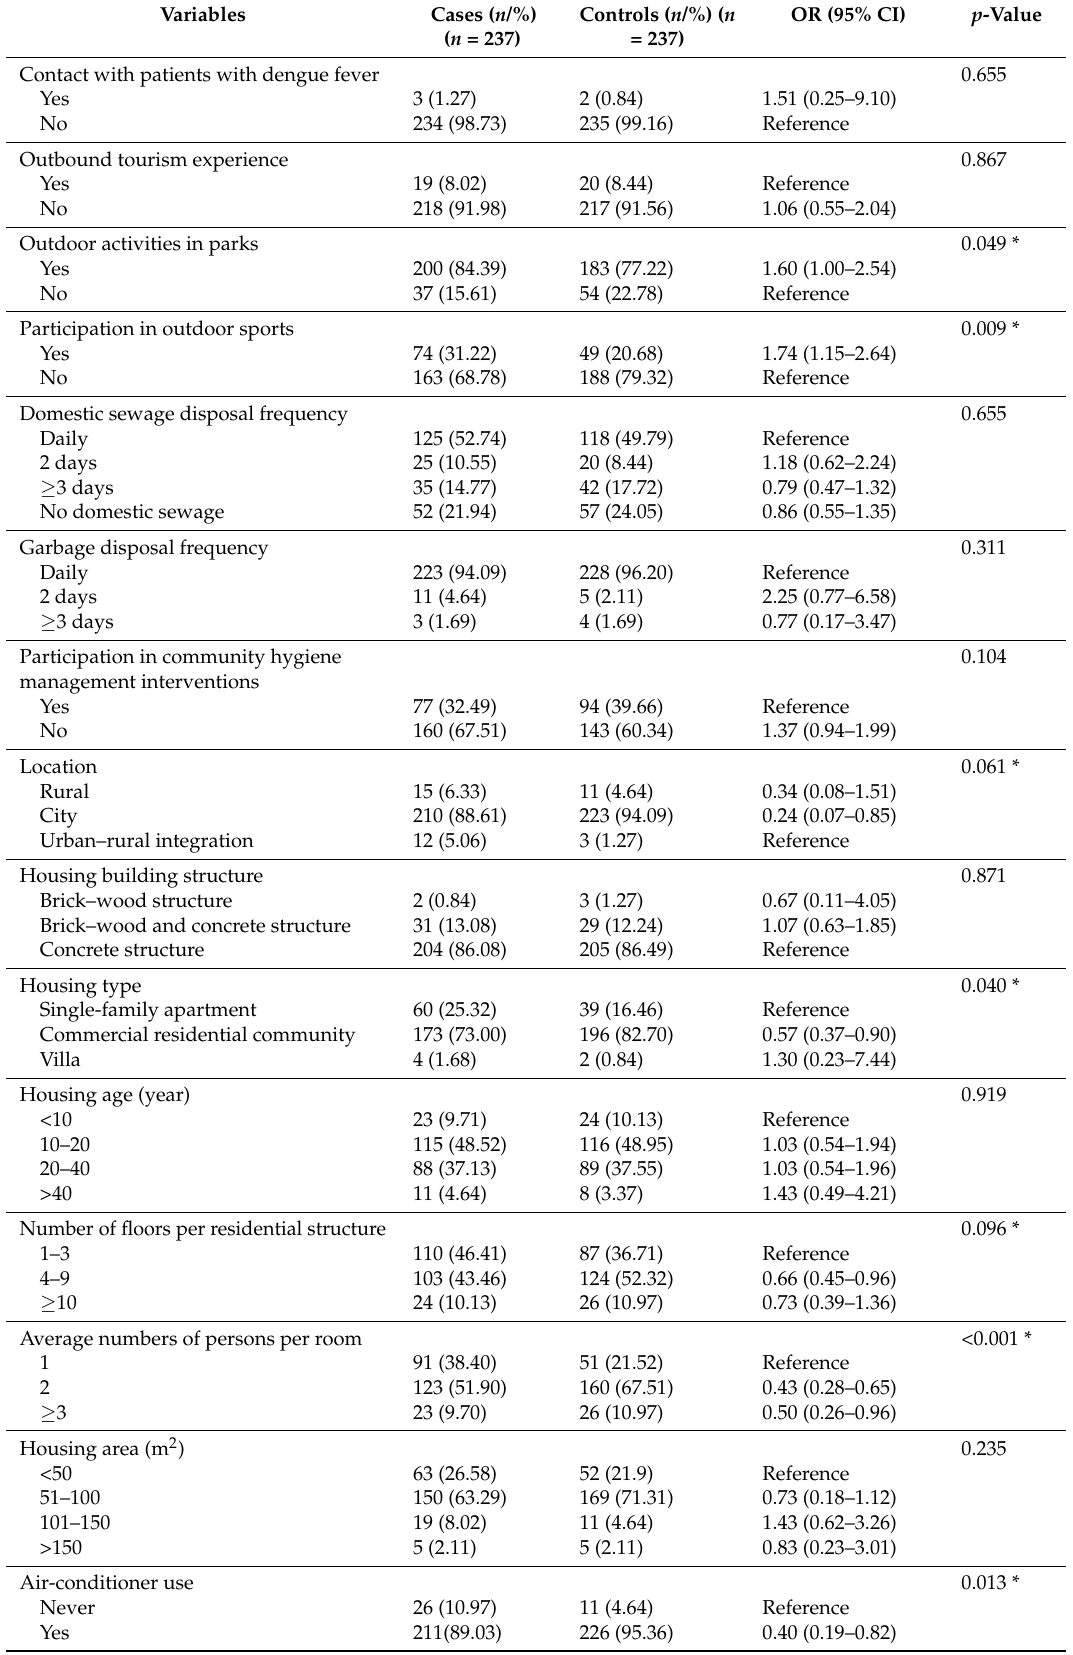
Table 2. Univariate analysis of risk factors for dengue virus